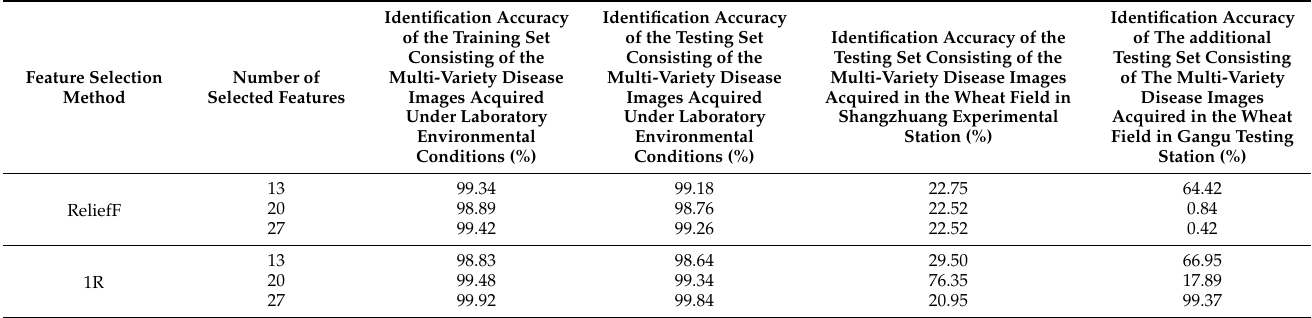
Table 8. Disease identification results of the BPNN models built with features selected based on the multi-variety disease image dataset consisting of images acquired under laboratory environmental conditions using feature selection methods including ReliefF and 1R,